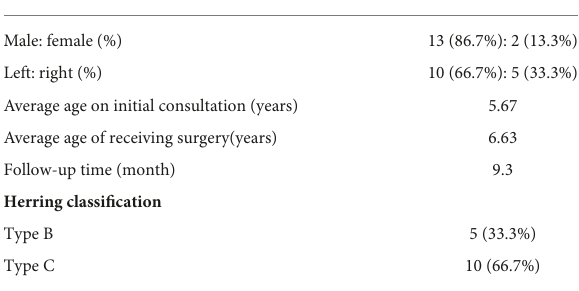
TABLE 2 Summary of demographic data of the Legg-Calvé-Perthes disease (LCPD) patients. Variables